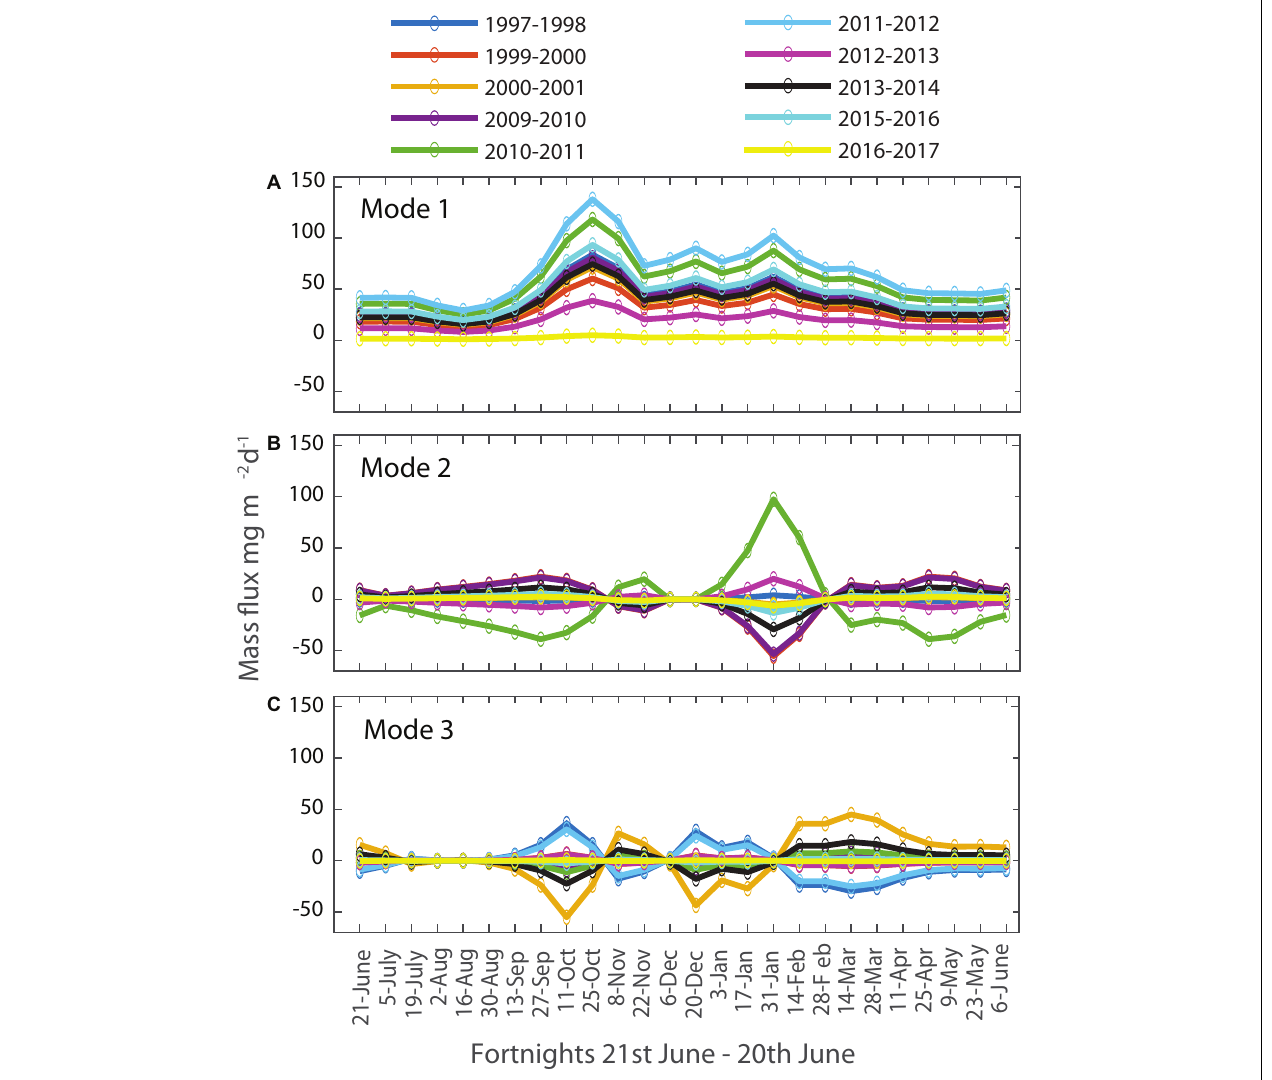
FIGURE 10 | Interannual variations in the seasonal 1000 m mass flux contributions of the Singular Value Decomposition Modes. (A) Mode 1: 79%, (B) Mode 2: 8%, (C) Mode 3: